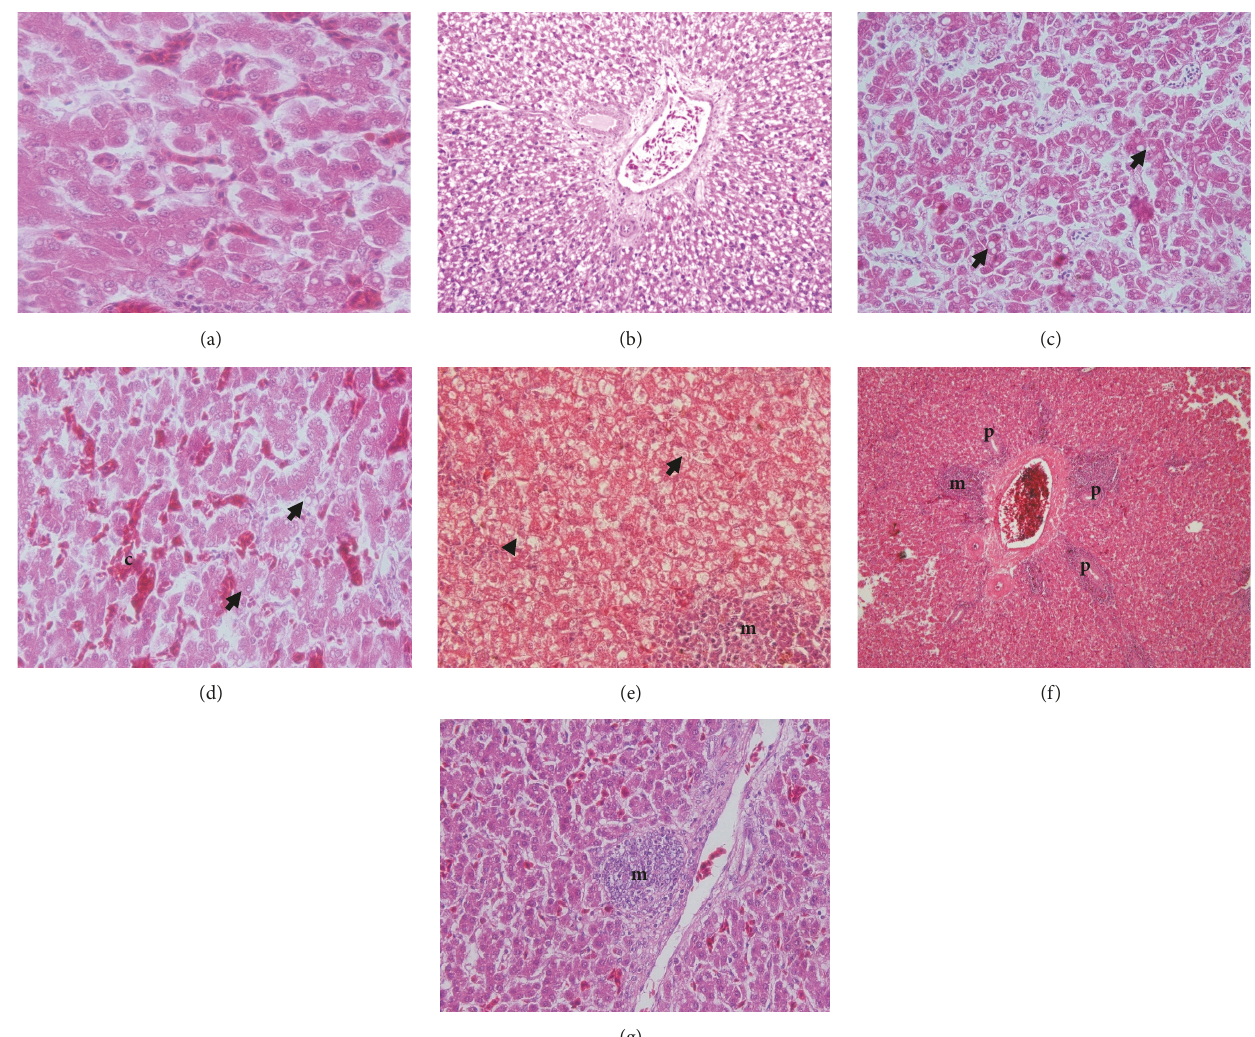
Figure 4: Effect of 5% SAP on the liver histopathology in the broiler chicken fed a diet with naturally contaminated with AF on day 21. The normal appearance of liver hepatocytes in group II (a); severe lipid degeneration with mononuclear cells infiltration in group III (6/6 samples) (b); lipid droplet (arrow) inside the cytoplasm of hepatocytes due to lipid degeneration in group IV (1/6 samples) (c); lipid degeneration (arrow) with sinusoid congestion (c) in group V (2/6 samples) (d); lipid degeneration (arrow) and hydrophobic degeneration (arrowhead) with mononuclear cells infiltration (m) in group V (2/6 samples) (e); bile-duct proliferation (p) and mononuclear cells infiltration (m) on the portal triad area in group VI (3/6 samples) (f); local mononuclear cells infiltration (m) in group VI (3/6 samples) (g). H&E, 10 × (b, f); 40 × (e); 100 × (c, g); 1000 × (a,